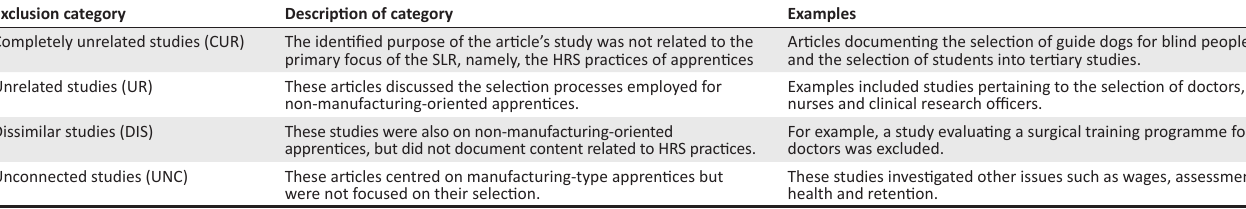
TABLE 2: Exclusion categories used in the systematic literature